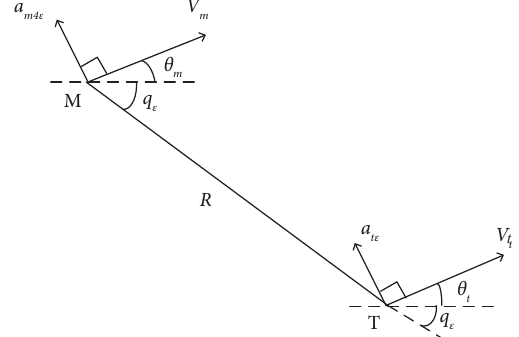
Figure 1. Engagement geometry of the leading interceptor and